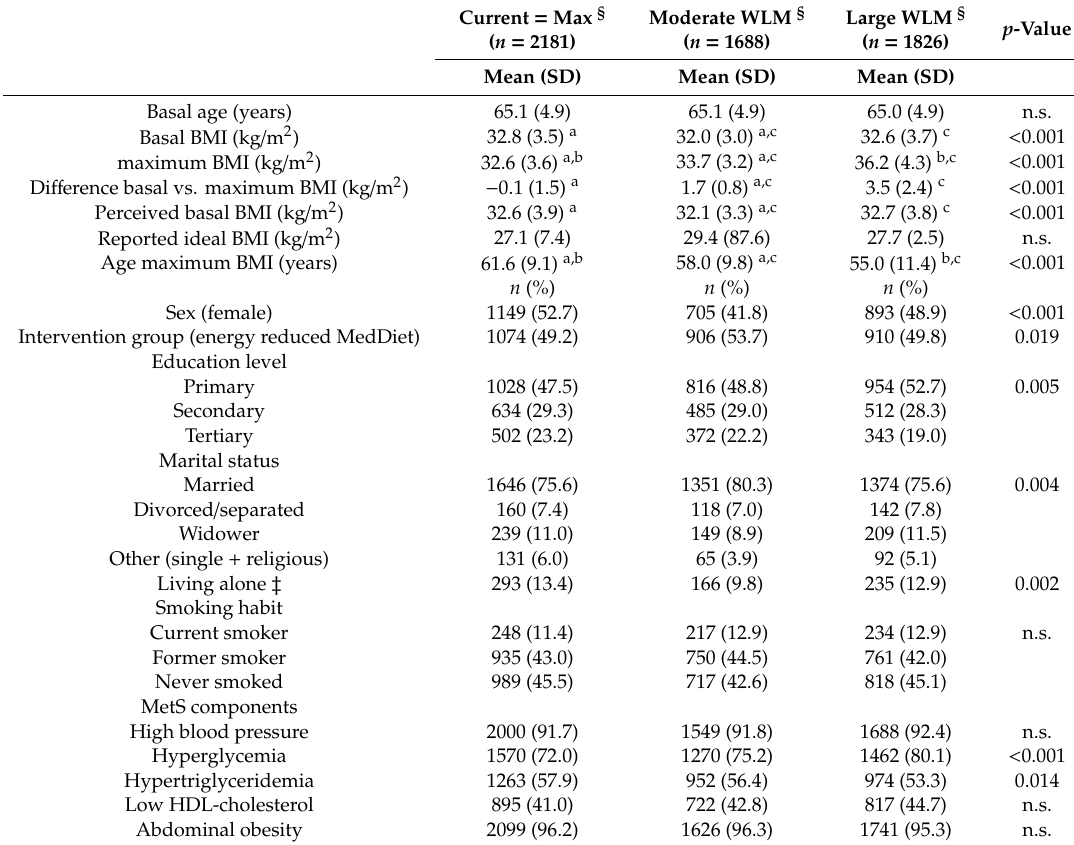
Table 1. Baseline characteristics according to maximum weight and BMI at